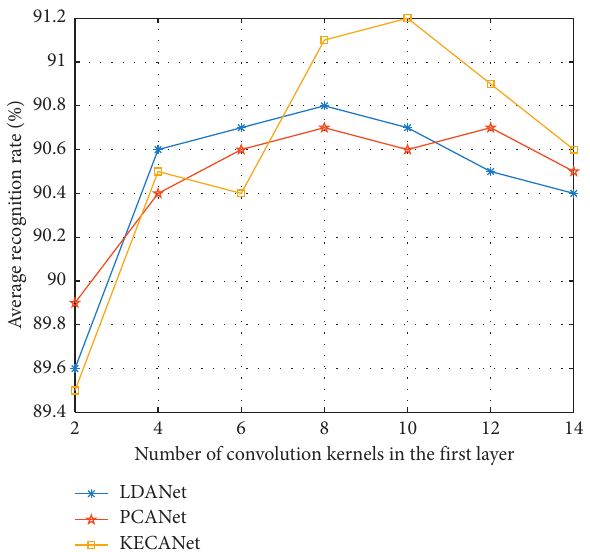
Figure 17: The average recognition rate corresponding to different values of L